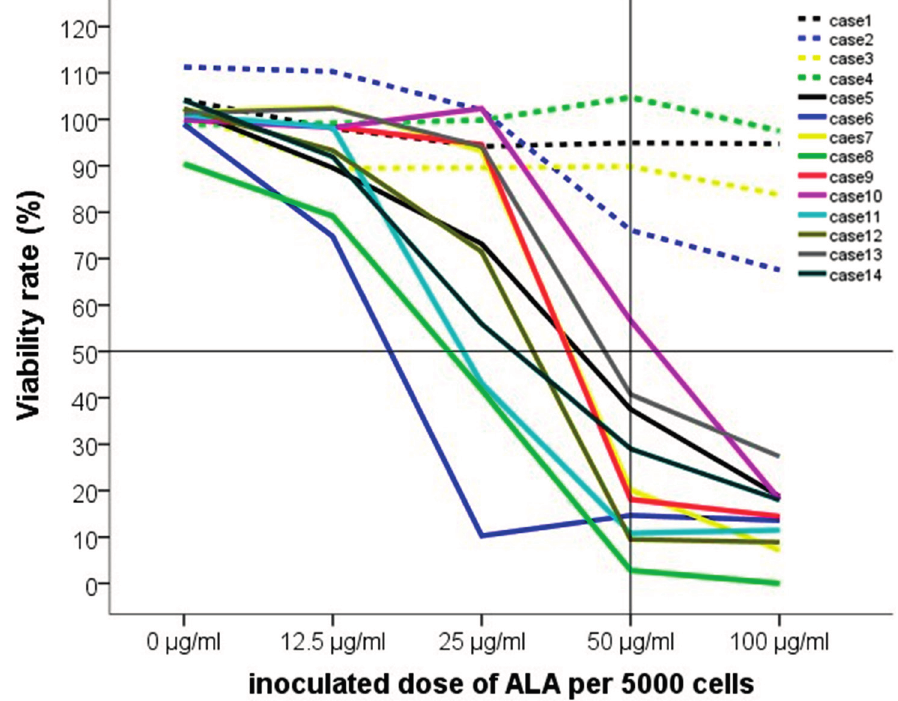
Figure 4. The courses of cell viability in each experiment. Note: the dashed lines show the four EMA negative populations (cases 1–4), the solid lines show the EMA positive cultures (cases